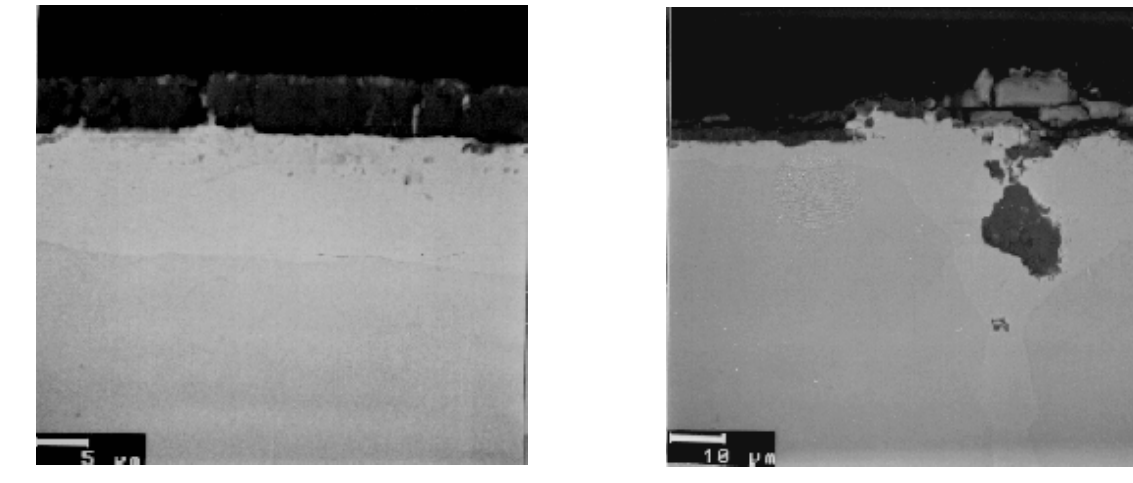
Figure 4. Cross-sectional morphologies of NiAl-20Fe alloy after oxidation at 1100 °C for 490 h (a) and 100 h (b)